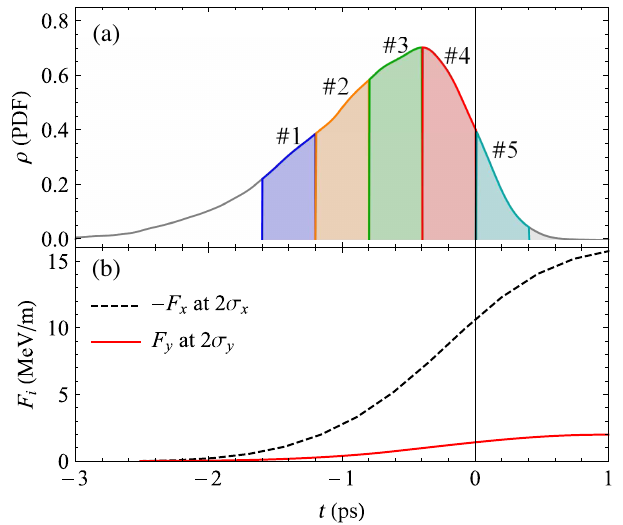
FIG. 8. (a) Skew Gaussian longitudinal bunch profile used in simulations at 1 GeVand 10 nC. Five longitudinal slices of 0.4 ps width each that were studied individually are also shown. (b) Transverse wakefield forces along the bunch on the structure axis. Horizontal F x is calculated at coordinates ð x; y Þ ¼ ð 2 σ x ; 0 Þ and vertical F y at ð x; y Þ ¼ ð 0 ; 2 σ y Þ , where σ x ¼ 500 μ m and σ ¼ 50 μ m. y represent 8.9 pC of the total 10 pC bunch charge. Horizontal rms widths σ x of longitudinal slices along the 5 m length of the structure are given in Figs. 9(a) and 9(b). Here, the vertical wakefields were deliberately removed by